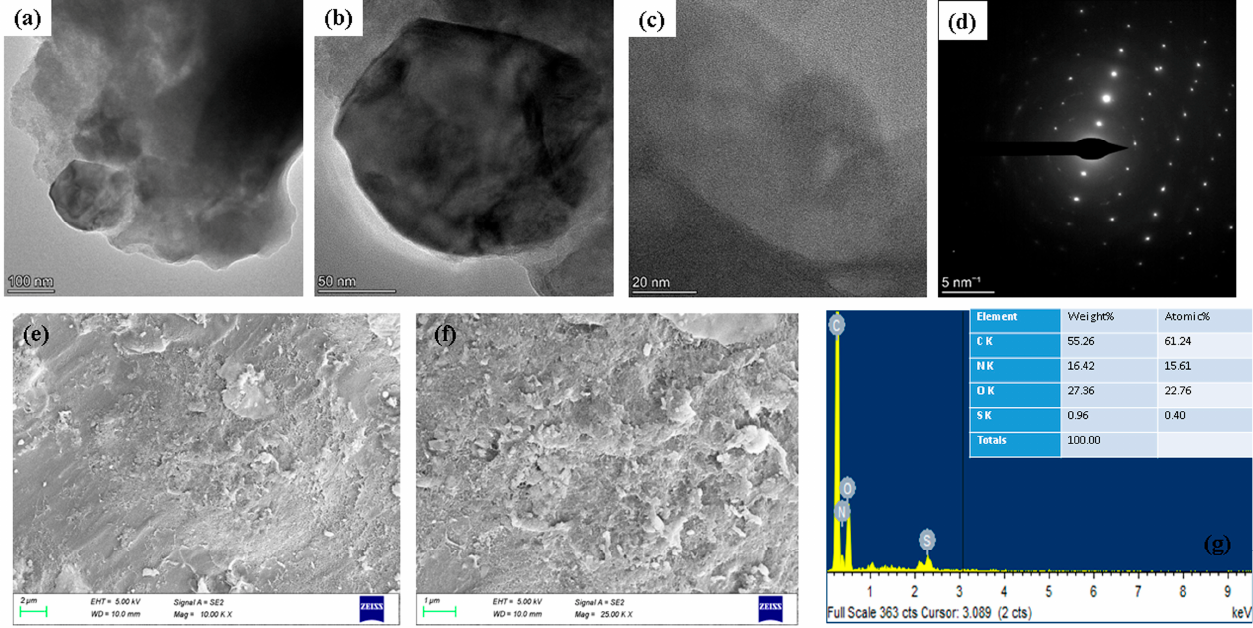
Figure 2. Electron microscopic imaging of albumin visnagin NPs lower and higher magnification TEM images ( a – c ) and SEAD patterns ( d ). Lower and higher magnification FESEM ( e , f ) and EDAX ( g ) spectrums.